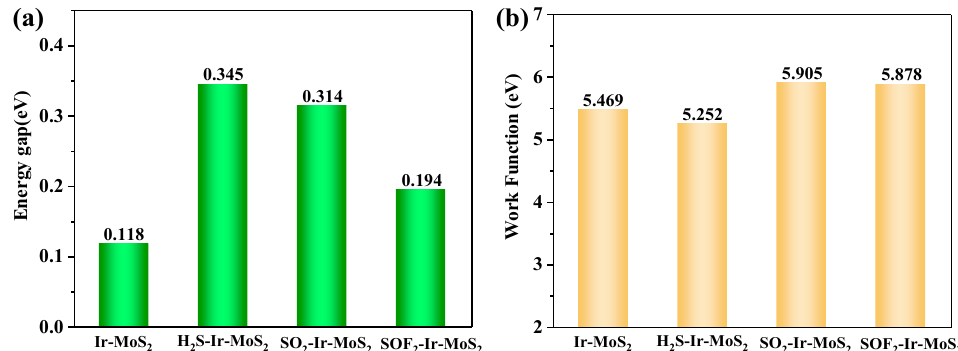
Figure 11. The ( a ) energy gap and ( b ) working function for different optimized systems. The predicted recovery time for the Ir-modified MoS 2 based sensor is displayed in Figure 12. The recovery time decreases with the increase in temperature due to the rapid desorption of gas molecules at high temperatures. The sequence of the recovery time for